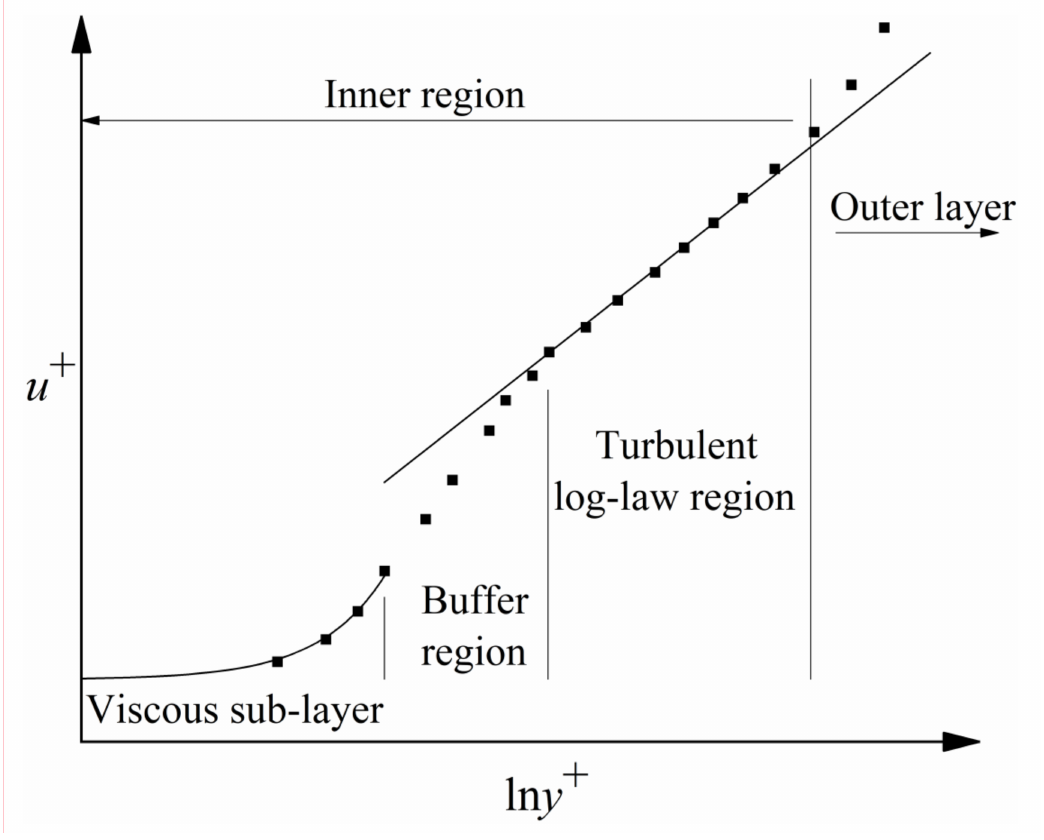
Figure 1. Velocity distribution near the bed ( u + = u / u ∗ , y + = u ∗ y ν